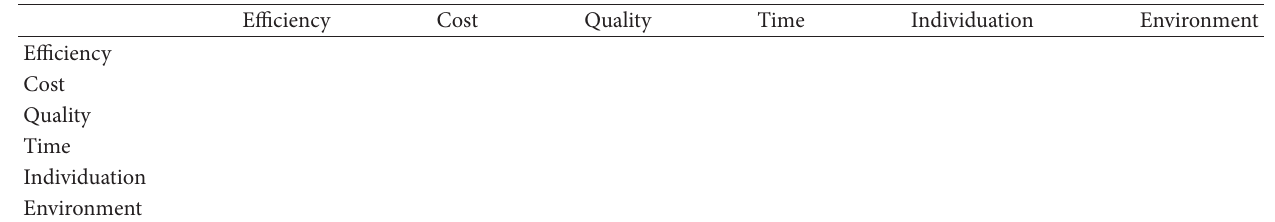
Table 3: Relative importance for customer needs.